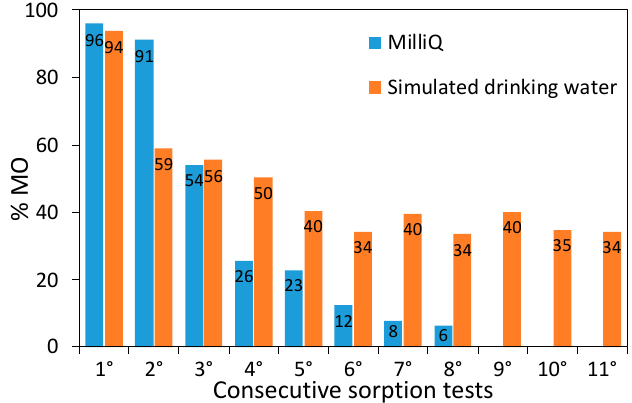
Figure 8. MO removal during sorption tests: consecutive runs of the 1 × 1 sample performed in both Milli- Q water and simulated drinking water.